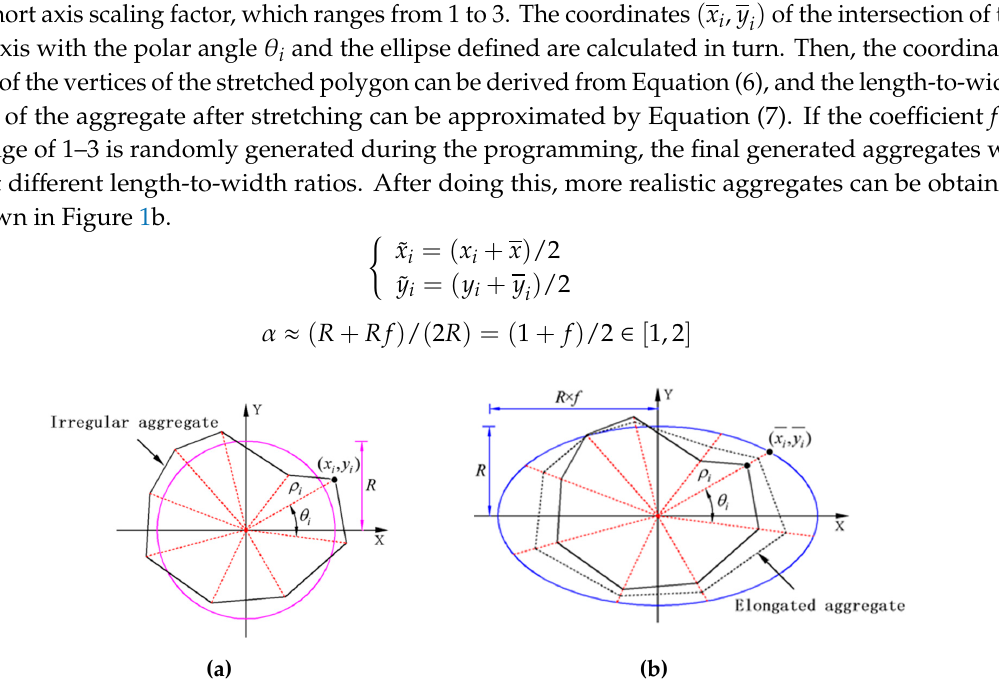
Figure 1. Illustration for generation schemes of ( a ) irregular aggregate and ( b ) elongated aggregate.